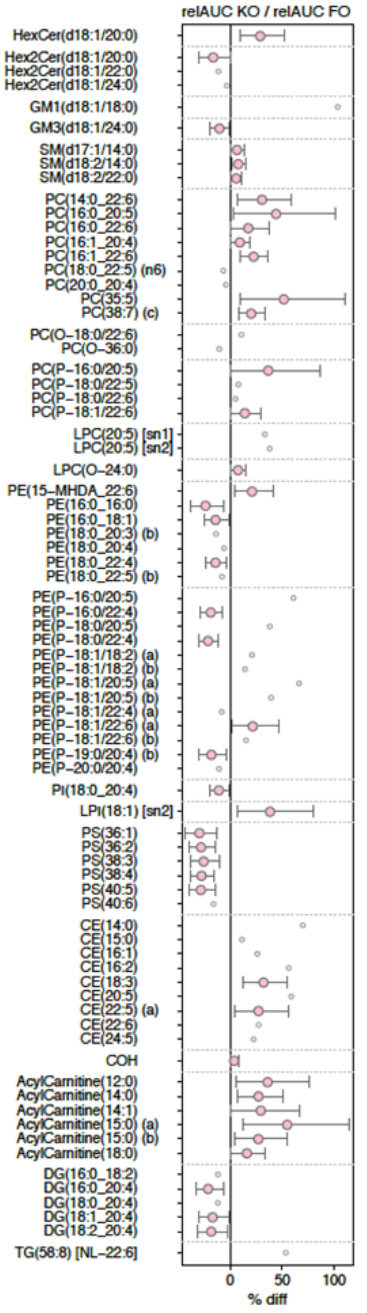
Figure 5. Percentage di ff erence in relAUCs between KO and FO treatments for 77 molecular lipid species of interest.The percentage di ff erences of the mean relAUC in KO relative to FO 30-day supplementations for 77 selected lipid molecular species are shown, with species organized by class across the y-axis. Of the selected lipids, 26 presented a nominally significantly greater relAUC in KO relative to FO, while 17 presented with a nominally significantly lower relAUC in KO relative to FO. Other selected lipids were included based on nominally significant (unadjusted p < 0.05) oil supplementation e ff ects as detected by the linear mixed models. Abbreviations: FO, fish oil; KO, krill oil; HexCer, mono-hexosylceramide; Hex2Cer, di-hexosylceramide; Hex3Cer, tri-hexosylceramide; GM1, GM1 ganglioside; GM3, GM3 ganglioside; SM, Sphingomyelin; PC, Phosphatidylcholine; PC(O), alkylphosphatidylcholine; PC(P), alkenylphosphatidylcholine; LPC, lysophosphatidylcholine; LPC(O), lysoalkylphosphatidylcholine; PE, phosphatidylethanolamine; PE(P), alkenylphosphatidylethanolamine; PI, phosphatidylinositol; LPI, lysophosphatidylinositol; PS, phosphatidylserine; CE, cholesteryl ester; COH, cholesterol; DG, diacylglycerol; TG [NL], triacylglycerol (neutral loss